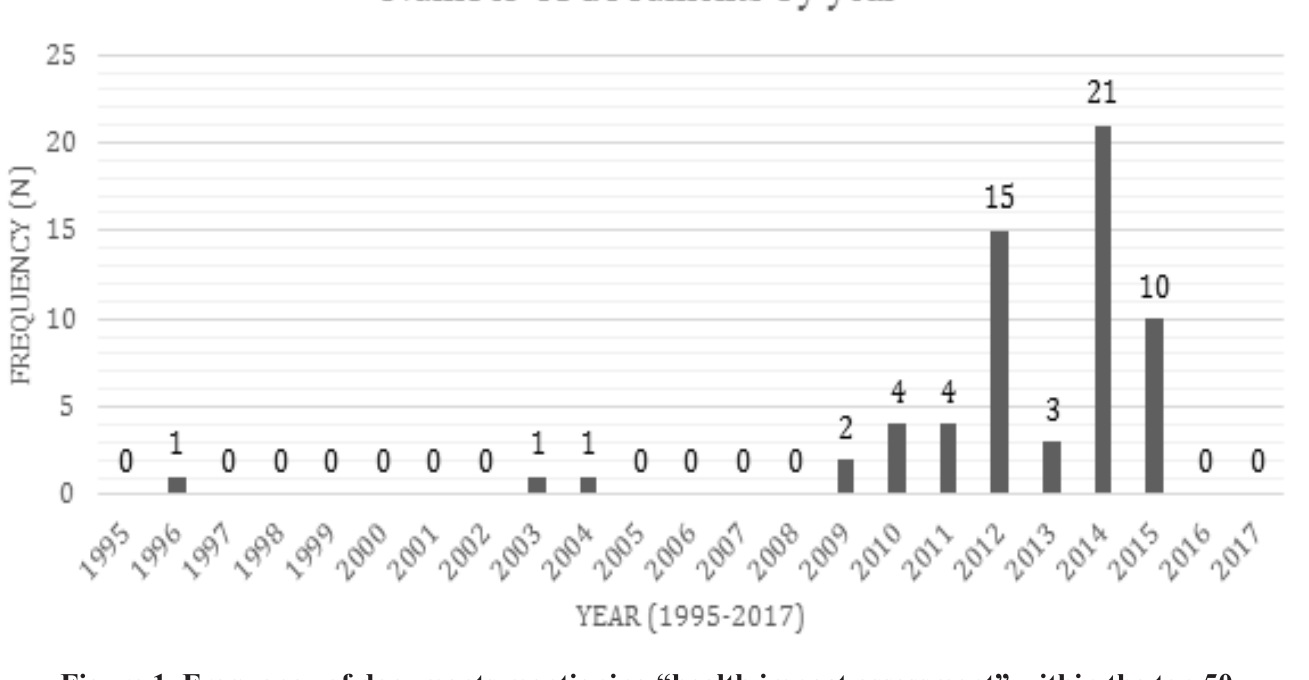
Figure 1. Frequency of documents mentioning “health impact assessment” within the top 50 mostly widely circulated U.S. newspapers of 2014 with publication dates between 1990 and January 31, 2017